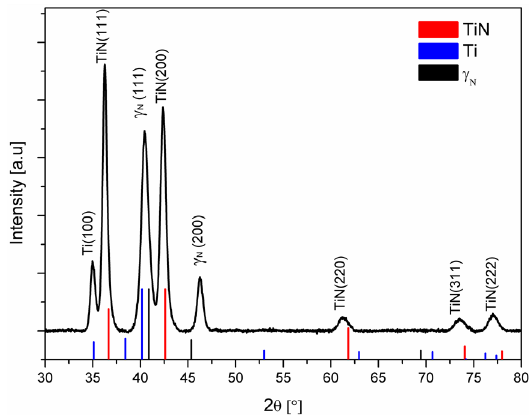
Figure 5. XRD Bragg-Brentano pattern of PBII&D Ti-TiN